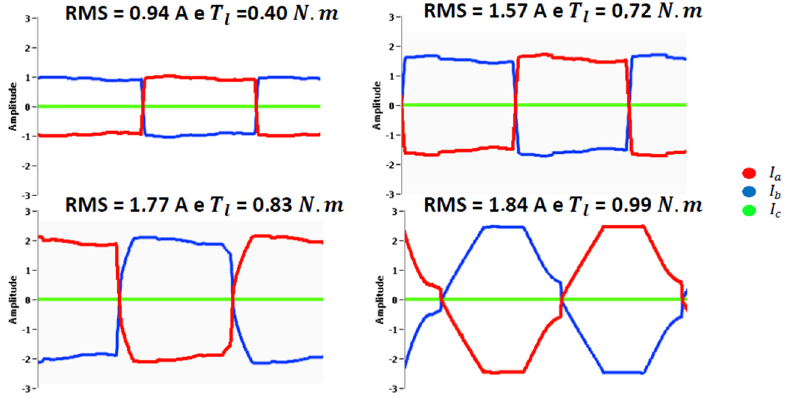
Figure 11. Load increase test in a BLDC motor operating in phase fault condition under proposed flexibilization on reduction current strategy.